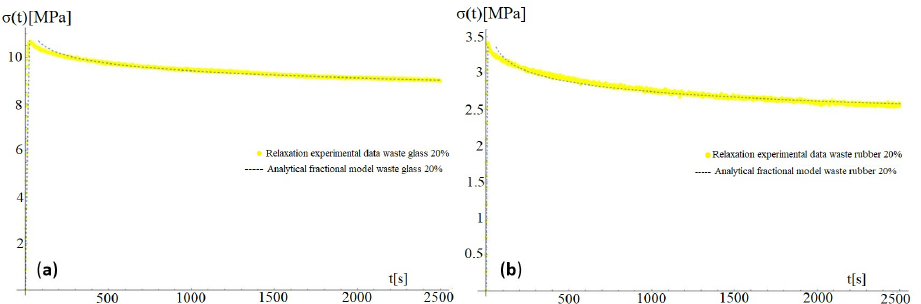
Figure 1. Comparison of best fitting between experimental relaxation data and the spring-pot analytical model for: ( a ) 20% glass powder composites and ( b ) 20% rubber powder